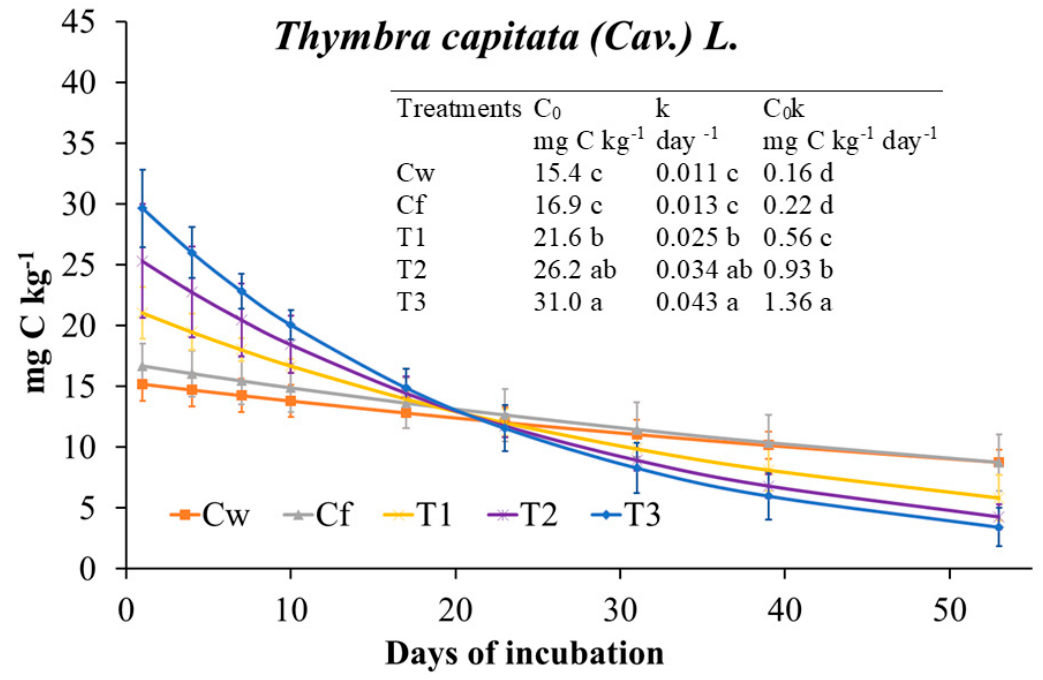
Figure 2. Microbial respiration rate fitted to the exponential first order decay function (Mineralized C = C 0 e − kt ) and derived parameters (C 0 , biological available C; k, turnover constant rate; C 0 k, initial potential rate of C mineralization) determined on soil treated with Thymbra capitata L. (Cav.) essential oil (EO) applied by irrigation. Treatments were: Cw (no Fitoil and EO application), Cf (0.03 µL Fitoil g − 1 of soil and no EO application), T1 (0.03 µL Fitoil g − 1 of soil and 0.31 µL EO g − 1 of soil), T2 (0.03 µL Fitoil g − 1 of soil and 0.67 µL EO g − 1 of soil), and T3 (0.03 µL Fitoil g − 1 of soil and 0.93 µL EO g − 1 of soil). Reported results are means ( n = 4). Bars indicate the standard deviations. Lower case letters indicate significant differences among treatments.